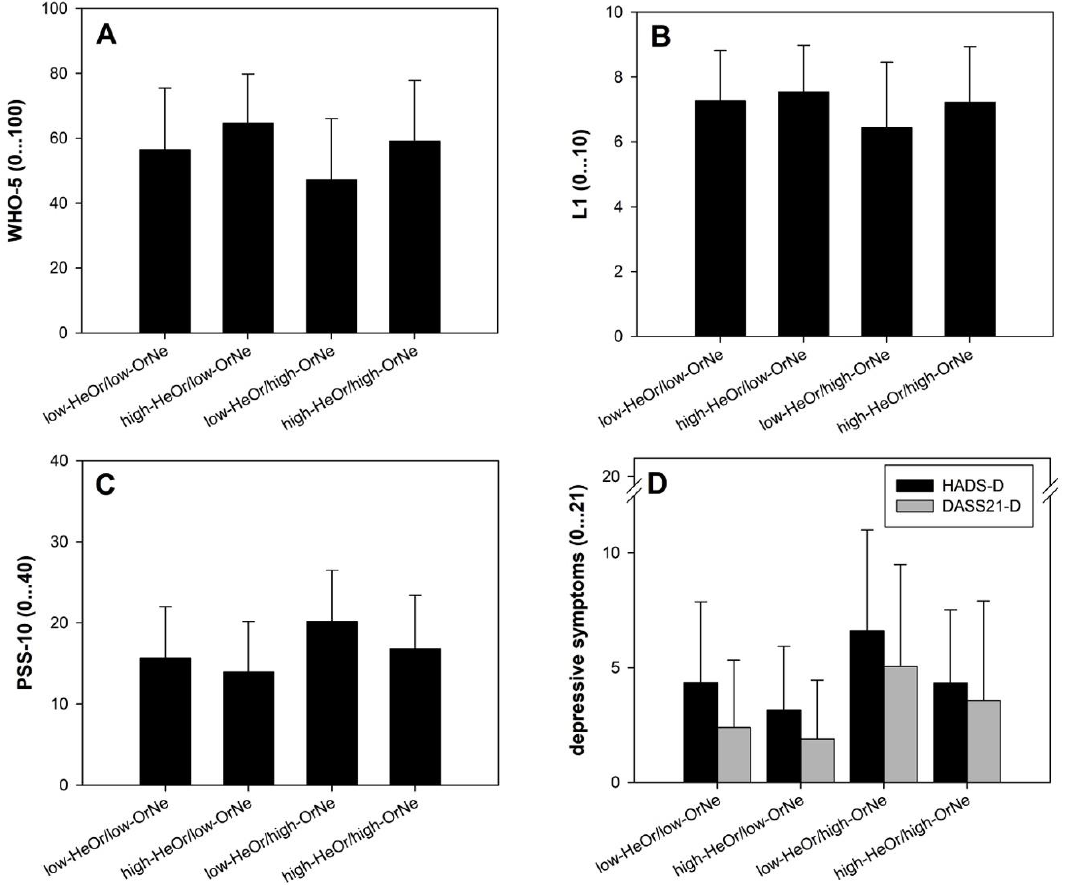
Figure 1. Illustration of the HeOr × OrNe interaction based on median split. HeOr, Healthy orthorexia; OrNe, Orthorexia nervosa; ( A ) WHO-5, Well-being Index; ( B ) L1, Life satisfaction Scale; ( C ) PSS-10, Perceived Stress Scale; ( D ) HADS, Depression Subscale & DASS21, Depression Subscale.